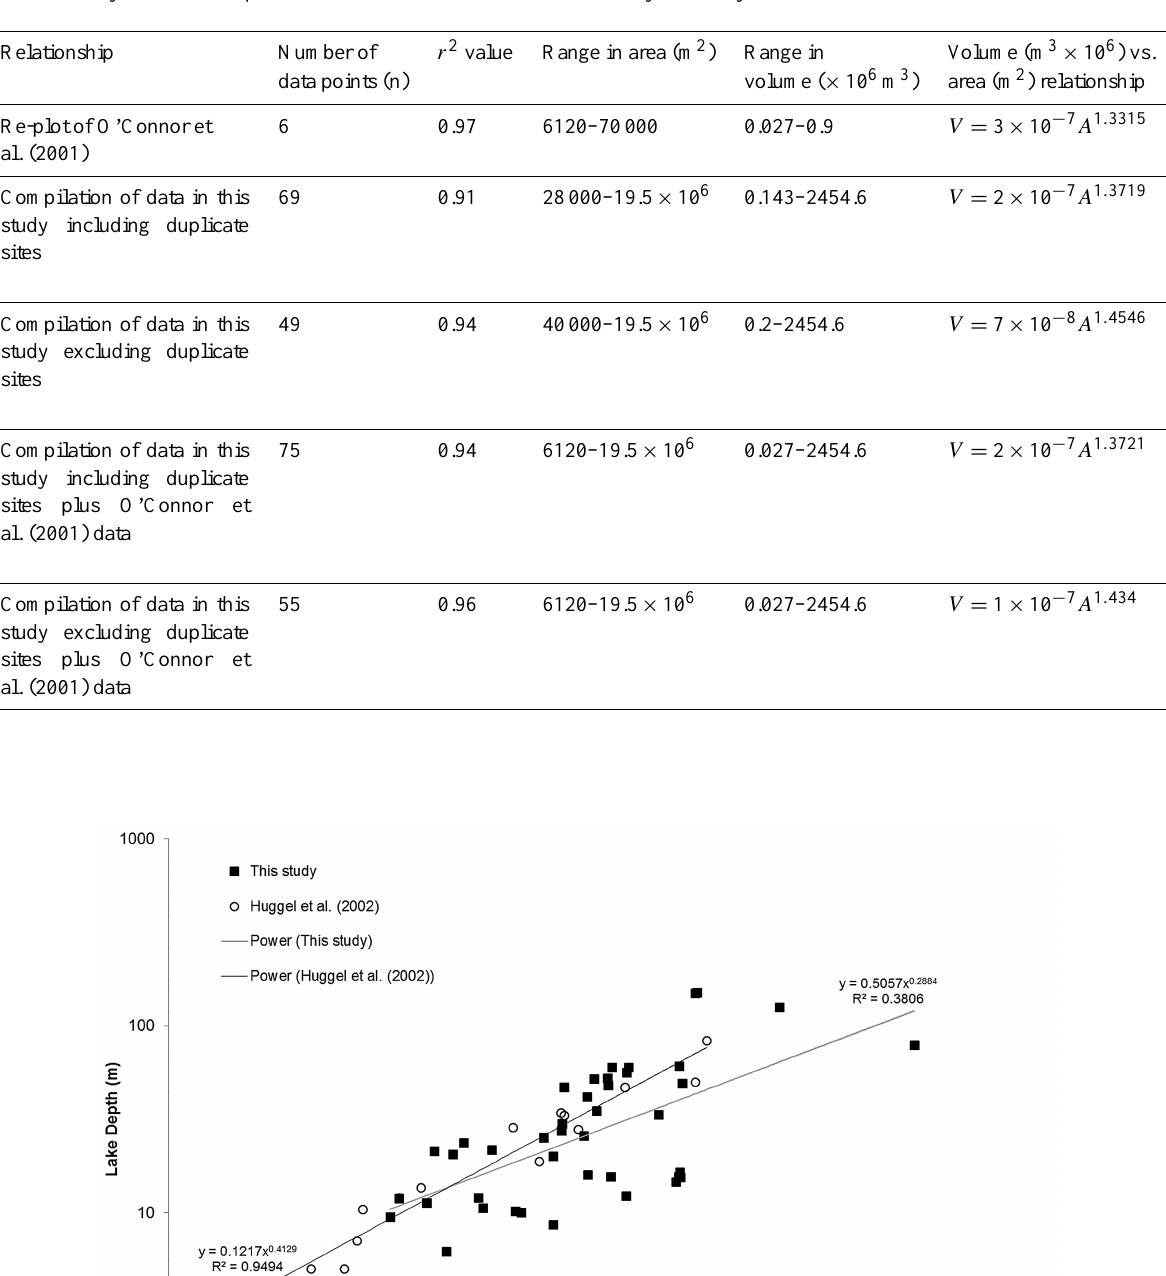
Table 2. Summary of relationships derived from measured lake area and bathymetrically derived volume data.